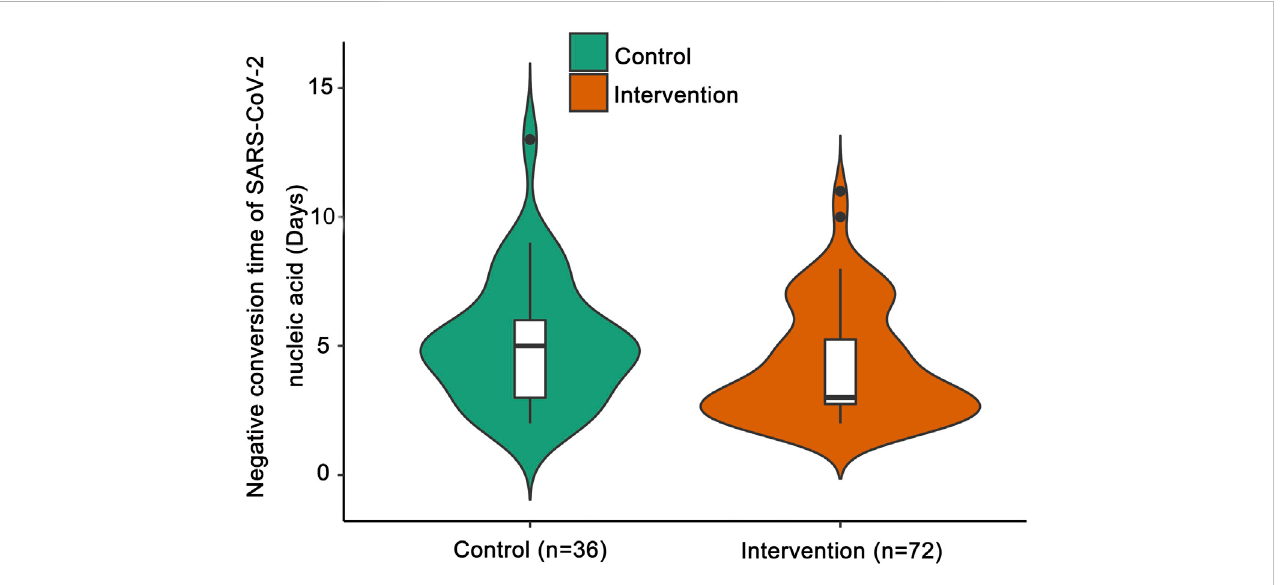
FIGURE 2 Negative conversion timeofSARS-CoV-2nucleic acid.The shapesoftheviolinplots representthedistributions ofdata.Theinsidesoftheviolinsarebox plots. C represents an outlier. Compared with the control group by the Mann-Whitney U test, the median negative conversion time of SARS-CoV-2 nucleic acid was signi fi cantly shorter in the intervention group ( p =